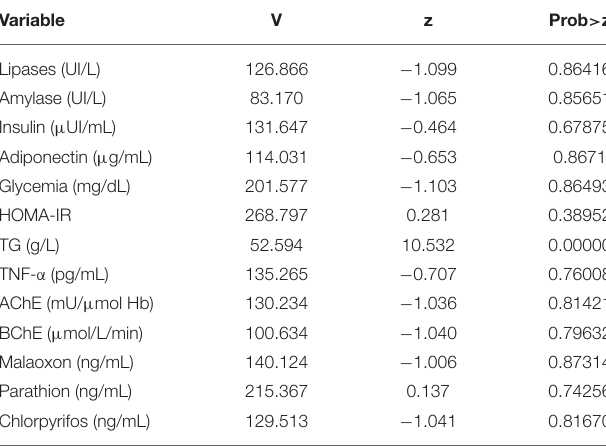
TABLE 1 | Normality values of the Shapiro-Wilk Normality